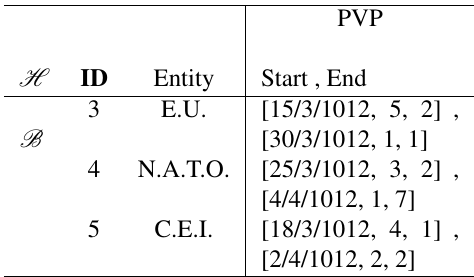
Table 12. Sample historical